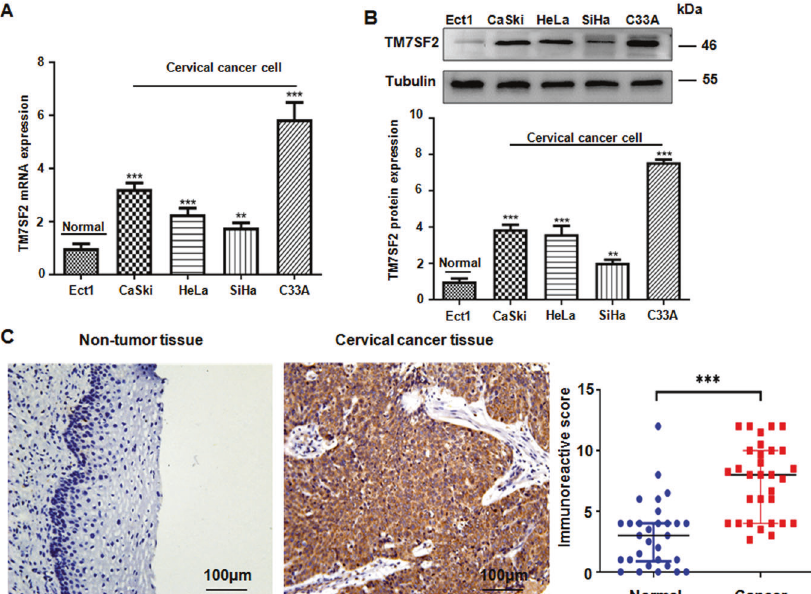
Fig. 1 The expression of TM7SF2 is upregulated in cervical cancer. A The expression level of TM7SF2 mRNA was measured by real-time RT- PCR in human cervical cancer cells compared with normal cervical epithelial cells. ** p < 0.01, *** p < 0.001 compared to Ect1 cells. B Top panel: the expression level of TM7SF2 protein was measured by western blotting in human cervical cancer cells compared with normal cervical epithelial cells. Bottom panel: quantitative results were illustrated. ** p < 0.01, *** p < 0.001 compared to Ect1 cells. C Left panel: the expression level of TM7SF2 protein was measured by IHC in human cervical cancer tissues and adjacent non-tumor tissues. Right panel: IHC scores were used to analyze the experimental results. The data were displayed as median with interquartile range. *** p < 0.001 compared to normal